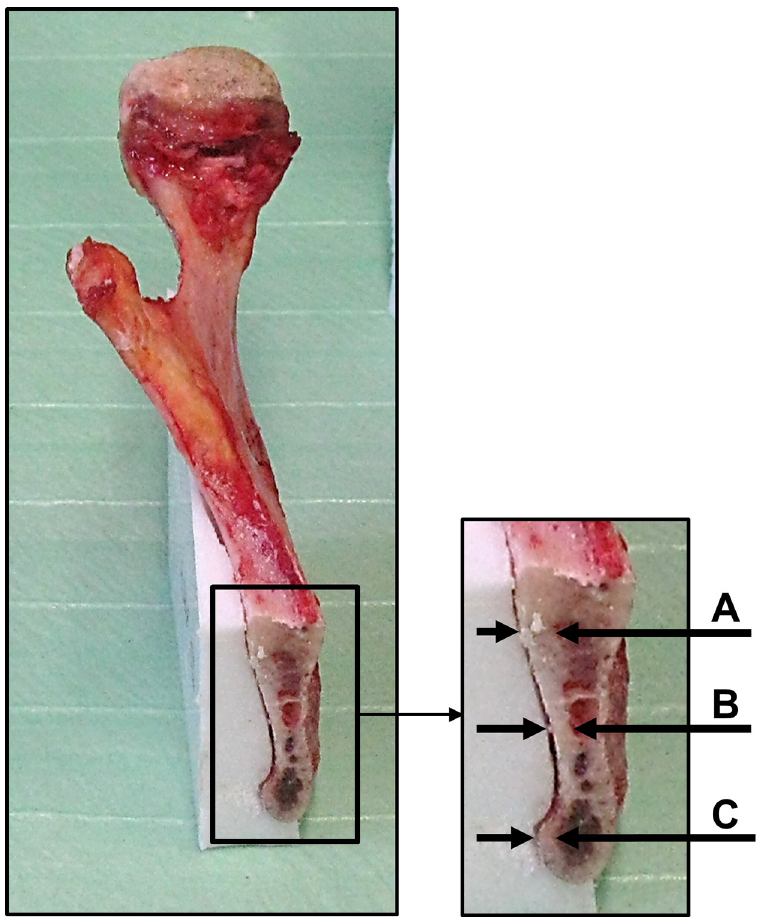
Fig 5. Measurement of the cortical thickness of the mandible at the resection plane of the right mandibular angle. Measurement of the cortical thickness of the mandible according to Heibel et al. [34].